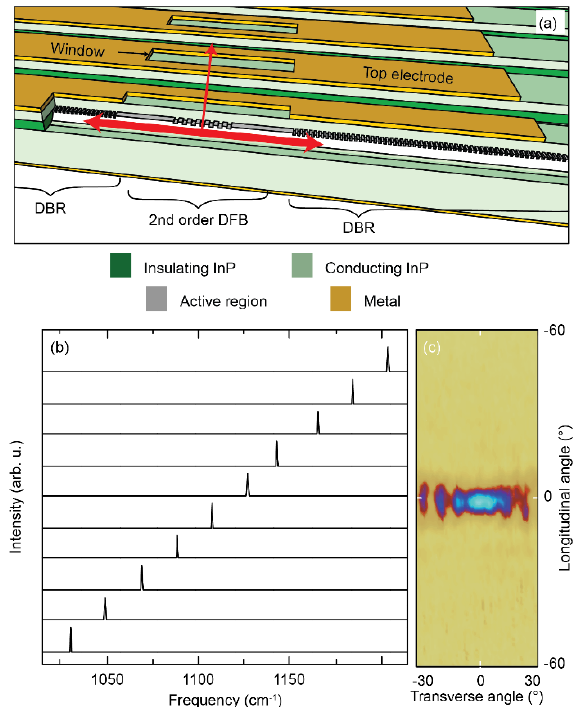
Figure 7. Surface emitting QCL array. ( a ) Schematic drawing of the surface emitting QCL array, revealing the first order DBRs, the second order DFB extractor, as well as the arrangement of the metallic top electrode including windows. The red arrows illustrate the path of the lasing mode; ( b ) laser spectra of the individual lasers in the array; and ( c ) far field intensity distribution of one laser in the array (transverse angle is rotated around the axis parallel to the active waveguide, longitudinal angle is rotated around the axis perpendicular to the active waveguide).